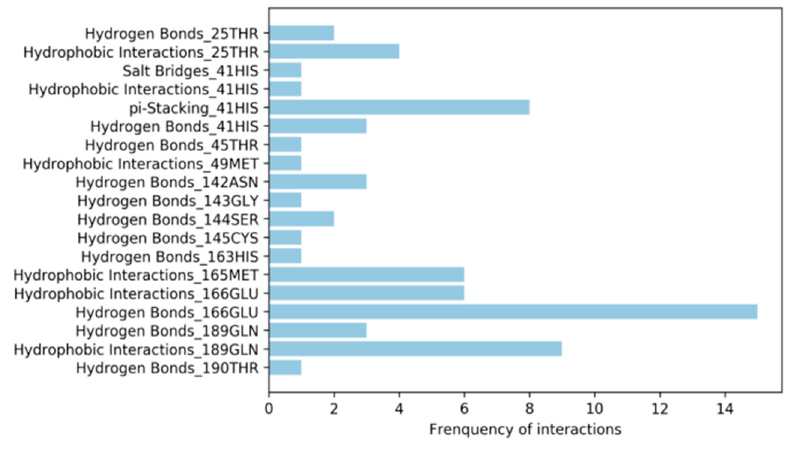
Figure 7. Non-covalent interactions calculated from 22 known inhibitors from SARS-CoV-2 Mpro.